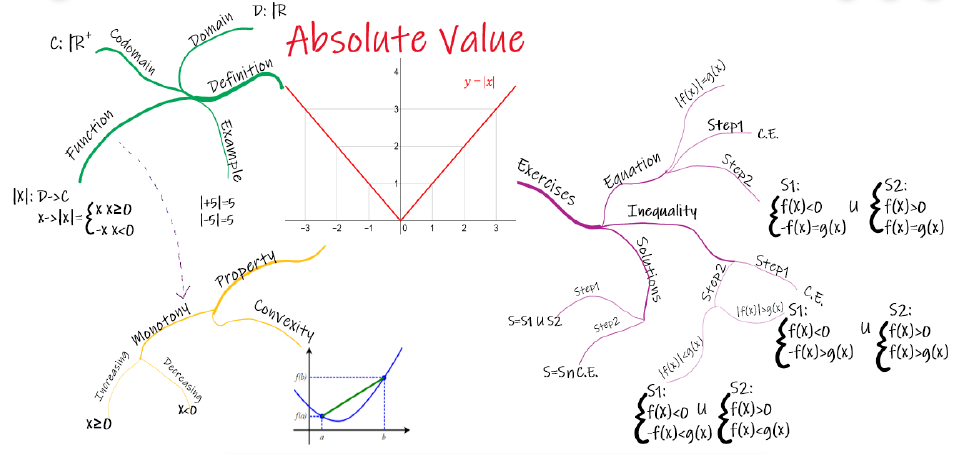
Figure 5.1 Example of a map built during the